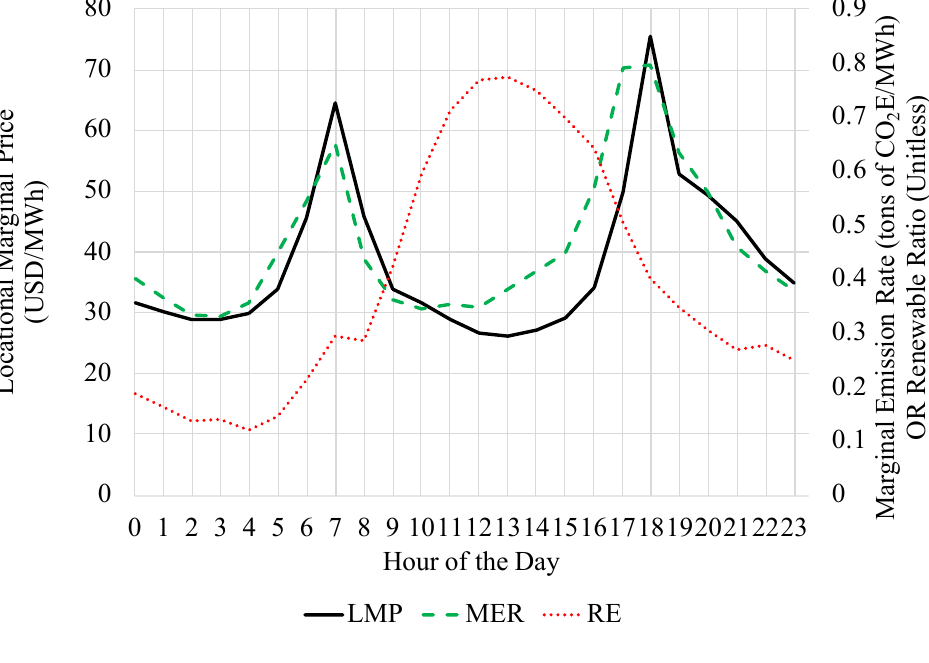
Figure 1. Example of locational marginal pricing, the marginal-emission rate, and the renewable ratio (2 November 2017, LMP node ID: BAYSHOR2-1-N001, SubLAP: